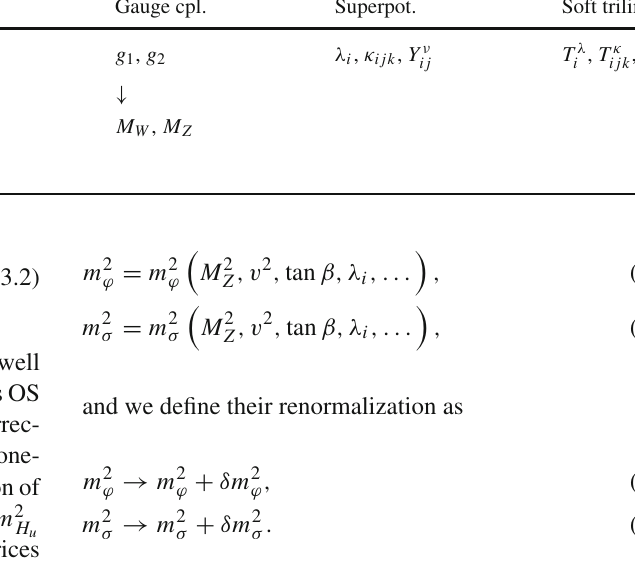
Table 1 Set of independent parameters initially entering the tree-level Higgs potential of the μν SSM in the first row, and final choice of free parameters after the substitutions defined in the text Soft masses vevs Gauge cpl. Superpot. Soft